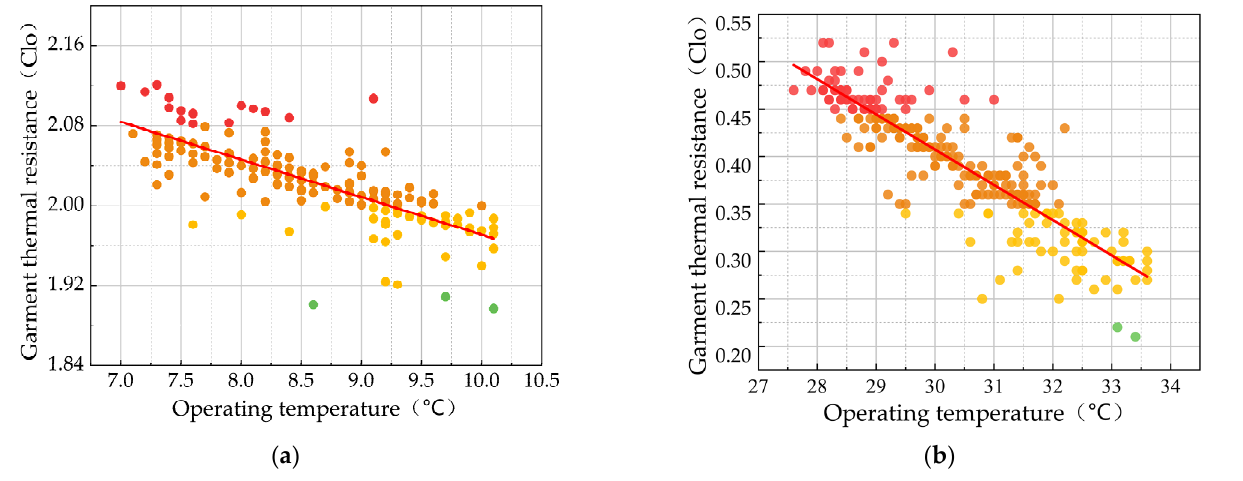
Figure 9. Relationship between the indoor operating temperature and thermal resistance of clothing in traditional residential houses in Xixinan Village. ( a ) Winter. ( b ) Summer.